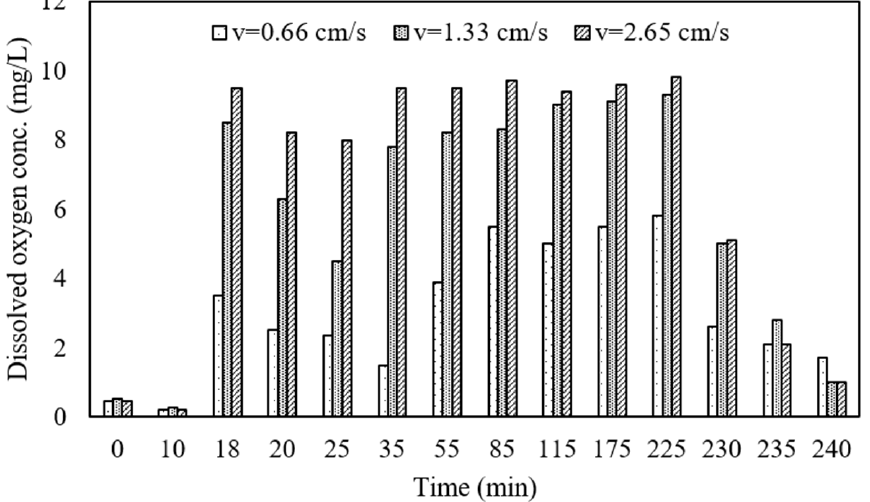
Figure 4. Dissolved oxygen concentration in the reactor at different aeration levels.